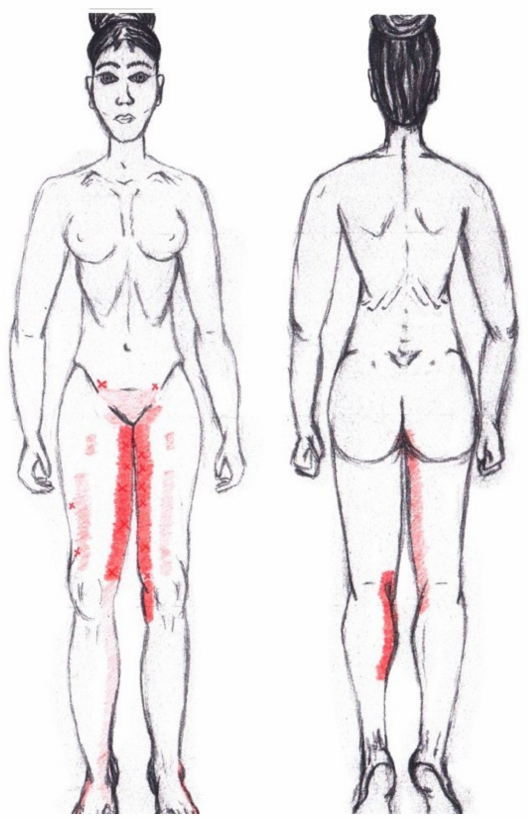
Figure 7. Graphical simulation of referred pain areas of the adductor magnus